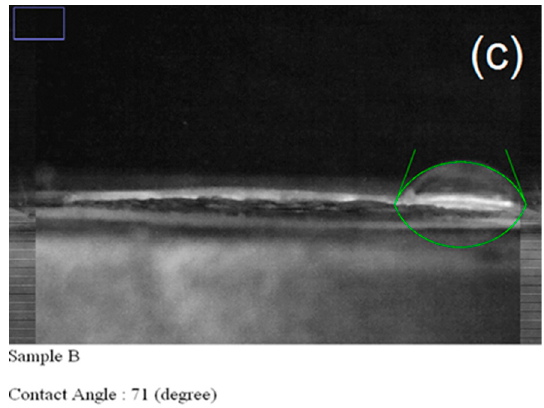
Figure 2. ( a ) SEM images, ( b ) fiber diameter distribution, ( c ) the contact angle of PVP/PVA nano- fibers.